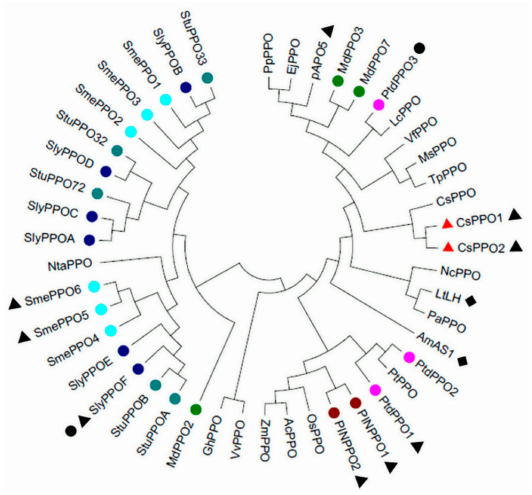
Figure 2. Phylogenetic analysis of PPO protein squences. The numbers on the tree branches represent bootstrap confidence values, as “Bootstrap” is 1000. The black triangles indicate wound-inducible; black dots indicate pathogen-inducible; black rhombuses indicate PPOs with biosynthetic functions. All sequence data may be found in GenBank, and differently colored bullet points represent different PPO gene families. Malus × domestica ( pAPO5 , P43309; MdPPO2 , AAK56323; MdPPO3 ,